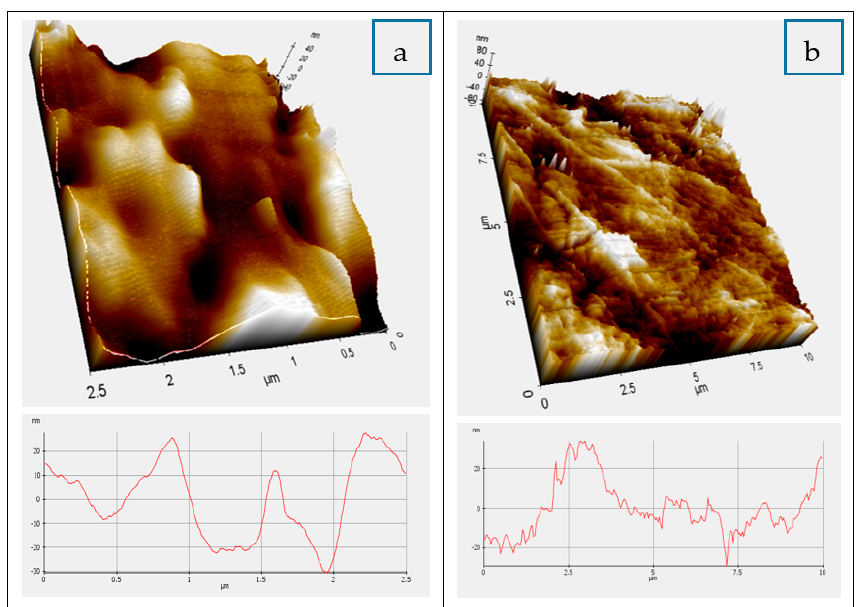
Figure 2. ( a ) Microscopy of natural allophane 3, ( b ) Natural allophane 4.